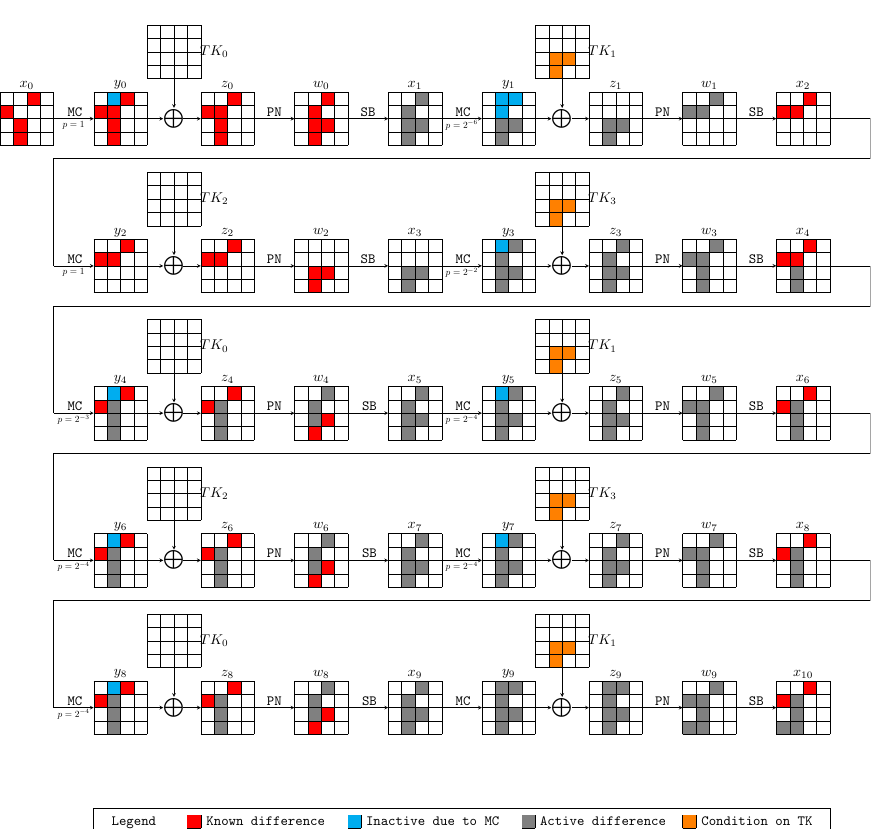
Figure 12: A 10-round truncated differential trail of CRAFT with probability 2 −